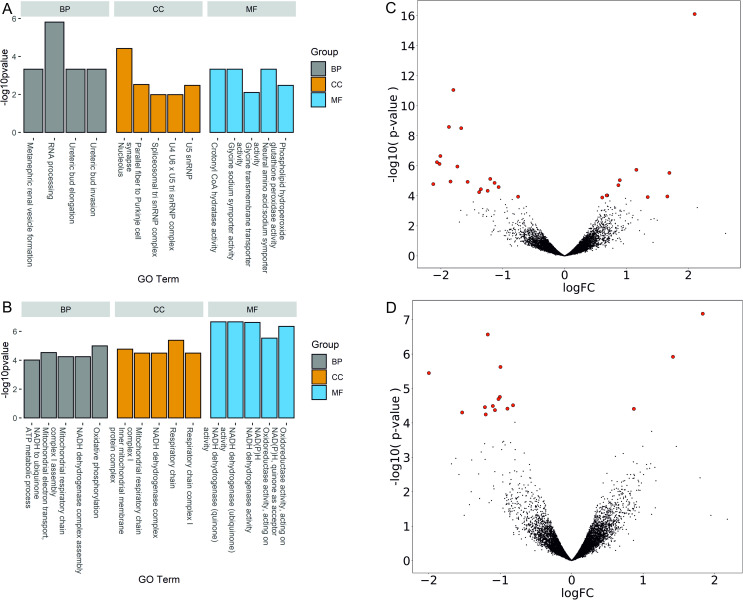
Differentially expressed genes and their representation in Gene Ontologies.Bar plots showing the top 5 enriched Gene Ontology terms in the comparison of responders against non-responders before administration of metformin (A) and three months after metformin therapy (B). Volcano plot represents the distribution of gene expression comparing responders against non-responders before administration of metformin (C) and three months after metformin therapy (D). Significance versus log2 fold change is plotted on the y and x axes, respectively, calculated using likelihood ratio test and edgeR. Red dots represent the significant DEGs (FDR < 0.05), black dots–non-significant genes. BP–biological process; CC–cellular component; MF–molecular function.